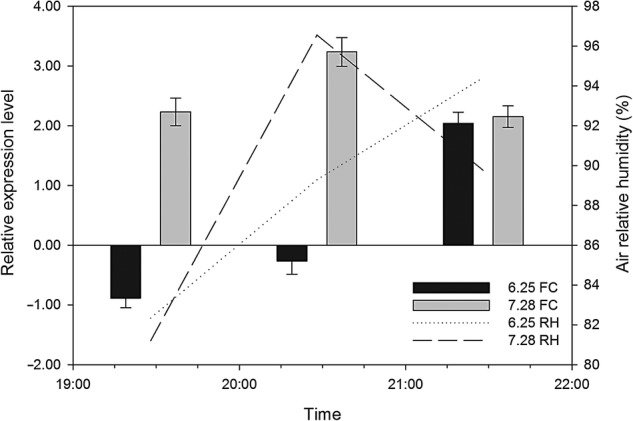
Comparison of the response of PIP1-2 with different air moisture levels under natural conditions for 2 days. The black bars and dotted line show the expression level of PIP2-1 and AirRh, respectively, on 25 June 2013. The grey bars and long dashed line show the expression level of PIP2-1 and AirRh, respectively, for 28 June 2013.